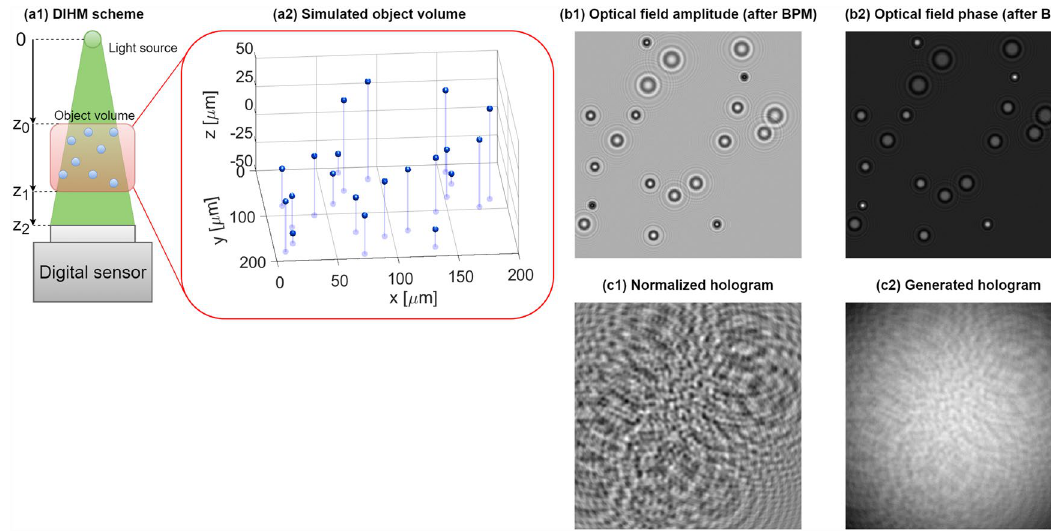
Figure 1. MSHoloSim engine working principle.